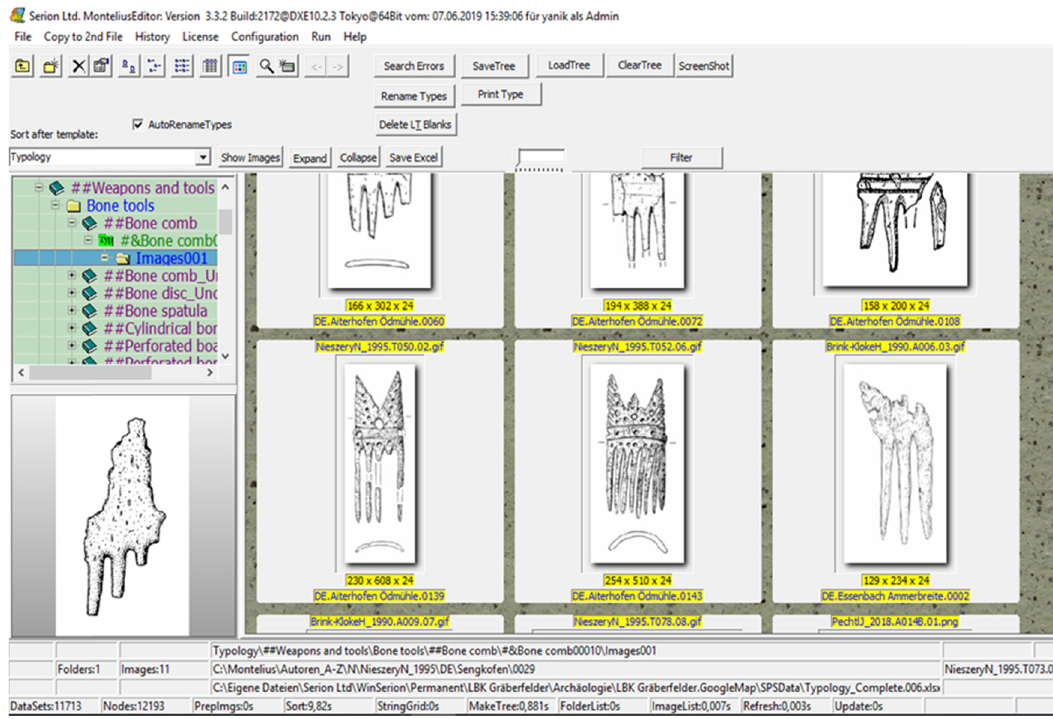
Figure 2: MonteliusEditor, typology of bone combs after being saved to the database via MonteliusEntry. This typology can be adjusted by Drag ’ n Drop the pictures into other type folders, renaming the types, multiply pictures if di ff erent typologies are needed, and many other functions.